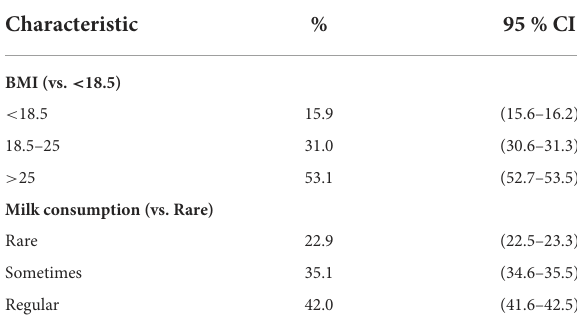
Figure 2), the weighted proportion of serum 25(OH)D